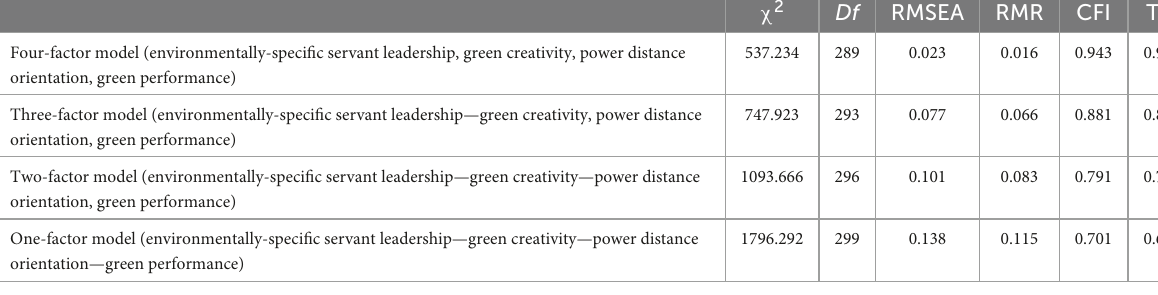
TABLE 3 Confirmatory factor analysis.